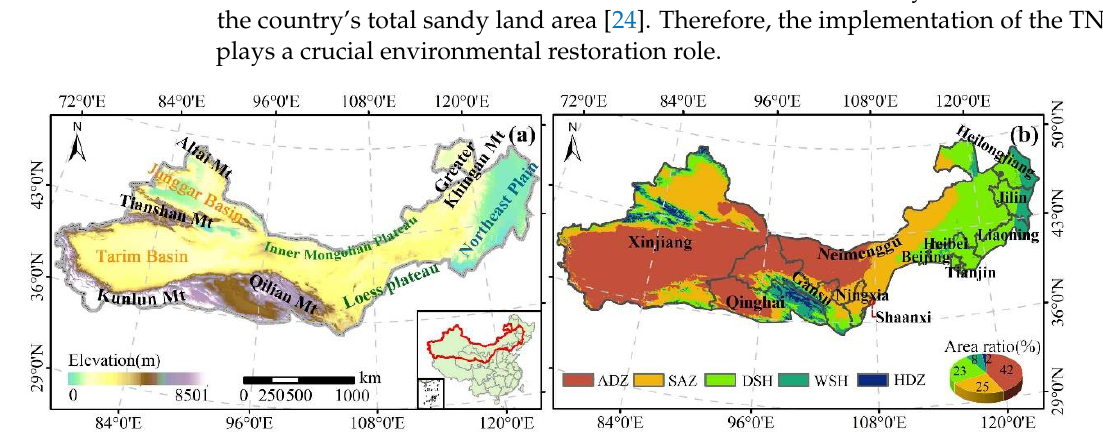
Figure 1. Topographic ( a ) and climatic zoning ( b ) of the study area.